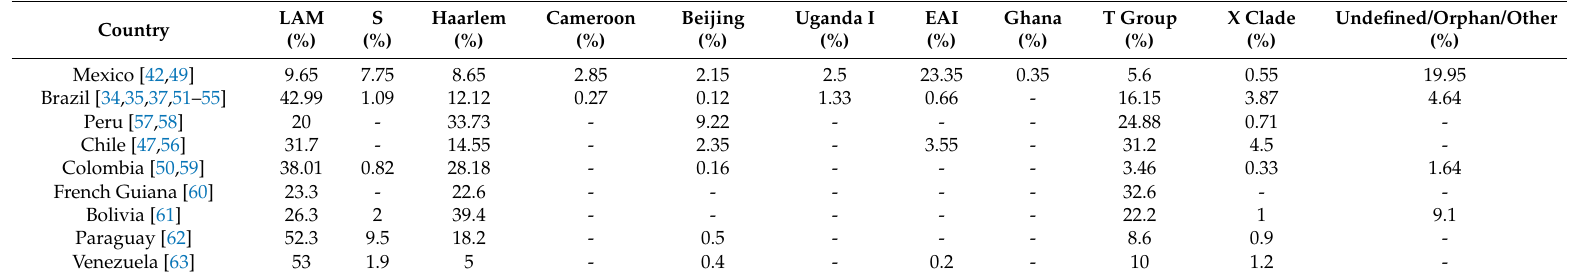
Table 2. The population density of South American MTB spoligotypes by